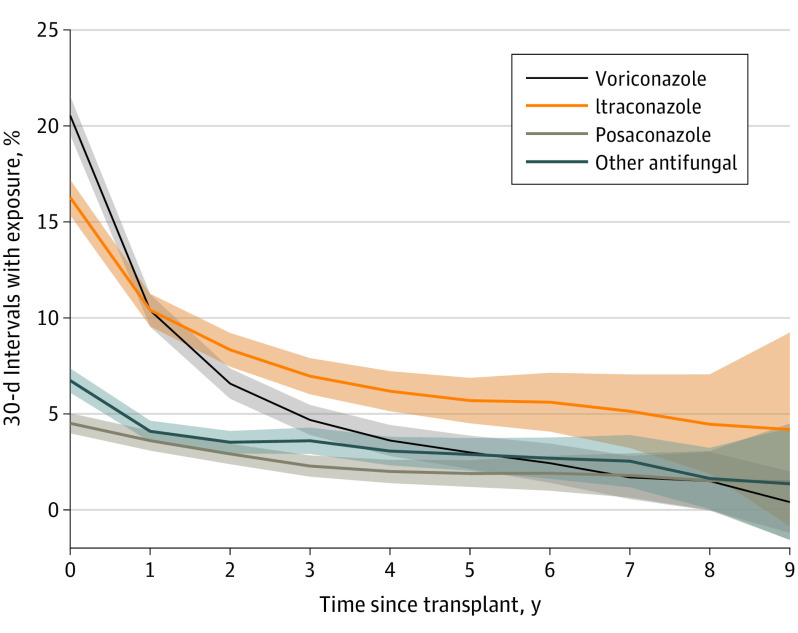
Antifungal Medication Exposure as a Function of Time Since TransplantExposure is measured as a claim for the specified antifungal medication observed. The percentages are calculated using only intervals with known exposure status. The other antifungal medication category includes the following medications: fluconazole, amphotericin B, caspofungin acetate, micafungin sodium, anidulafungin, and isavuconazonium sulfate. Shaded areas indicate 95% CI.